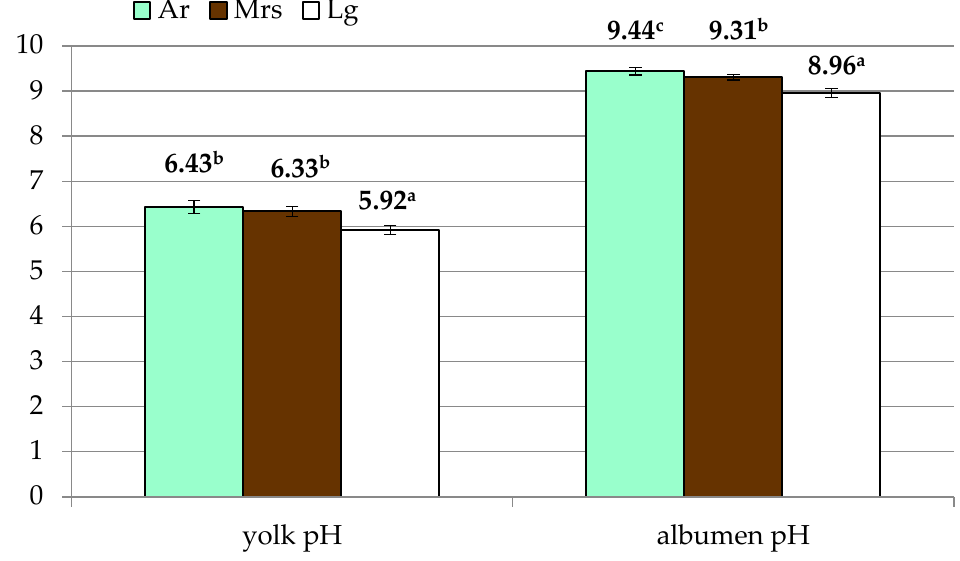
Figure 3. The yolk and albumen pH of eggs from three breeds of hens differentiated by the eggshell color. Ar—green (seledine) eggs from Araucana; Mrs—brown eggs from Marans; Lg—white eggs from Leghorn; a, b, c —means within row differ significantly at p ≤ 0.05 (Tukey test). Analysis of albumen quality (Table 3) showed differences in its weight and height. One of the visually examined trait of eggs quality was the presence of meat and blood spots in the egg content. Interestingly, both types of spots were found only in Marans eggs. In this group 6.7% of eggs demonstrated the presence of meat spots and 86.7% blood for Ar eggs with significantly lowest recorded for Lg. spots on yolk. In eggs from Ar or Lg no spots were found, and in this case the statistcal Table 3. The quality traits of the albumen of eggs from three breeds of hens differentiated by the eggshell color. Ar Mrs Lg Trait Weight (g) Height